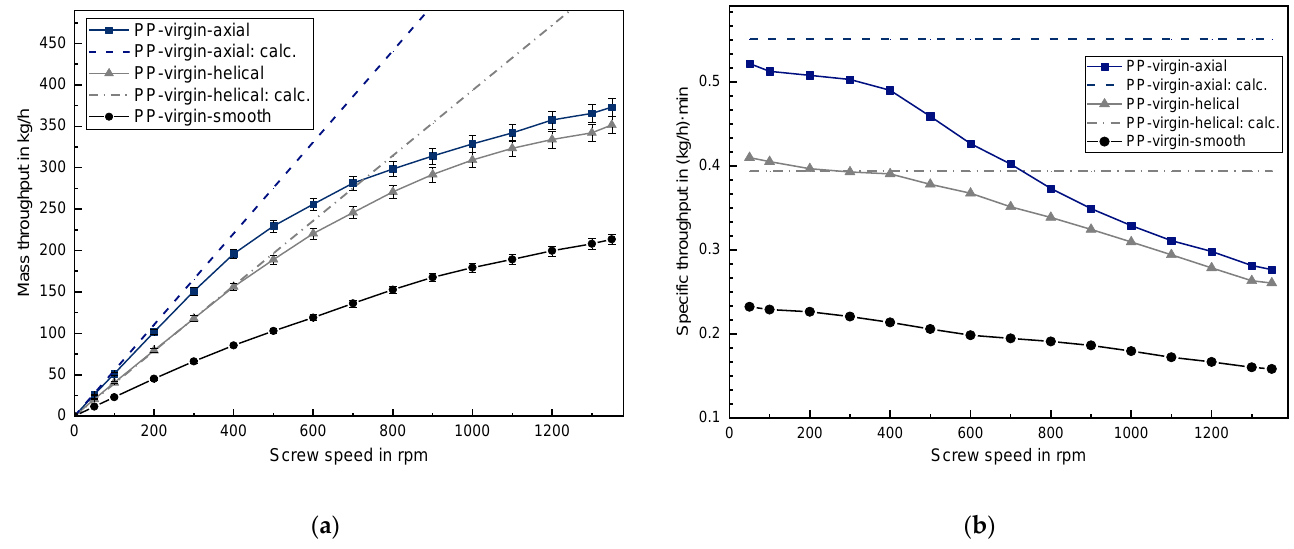
Figure 7. ( a ) Mass throughput and ( b ) specific mass throughput for the virgin PP granule. Regarding the prediction quality of the analytical approach, the calculated throughput perfectly matches with the measured throughput when utilizing the helically grooved barrel. The mean relative deviation between the calculated and the measured values is approximately 2% at 50–300 rpm in this case. This finding underlines the importance of taking the bulk density as a function of the dumping height into account in order to obtain appropriate throughput predictions.